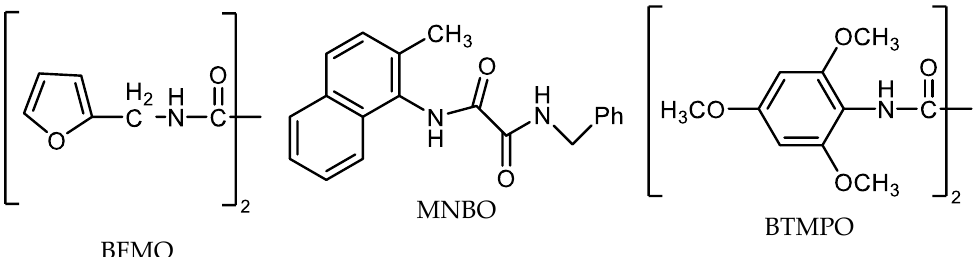
Figure 6. Structures of another highly effective oxalic acid diamide- and benzoin oxime-based ligands [44,47,83,84].